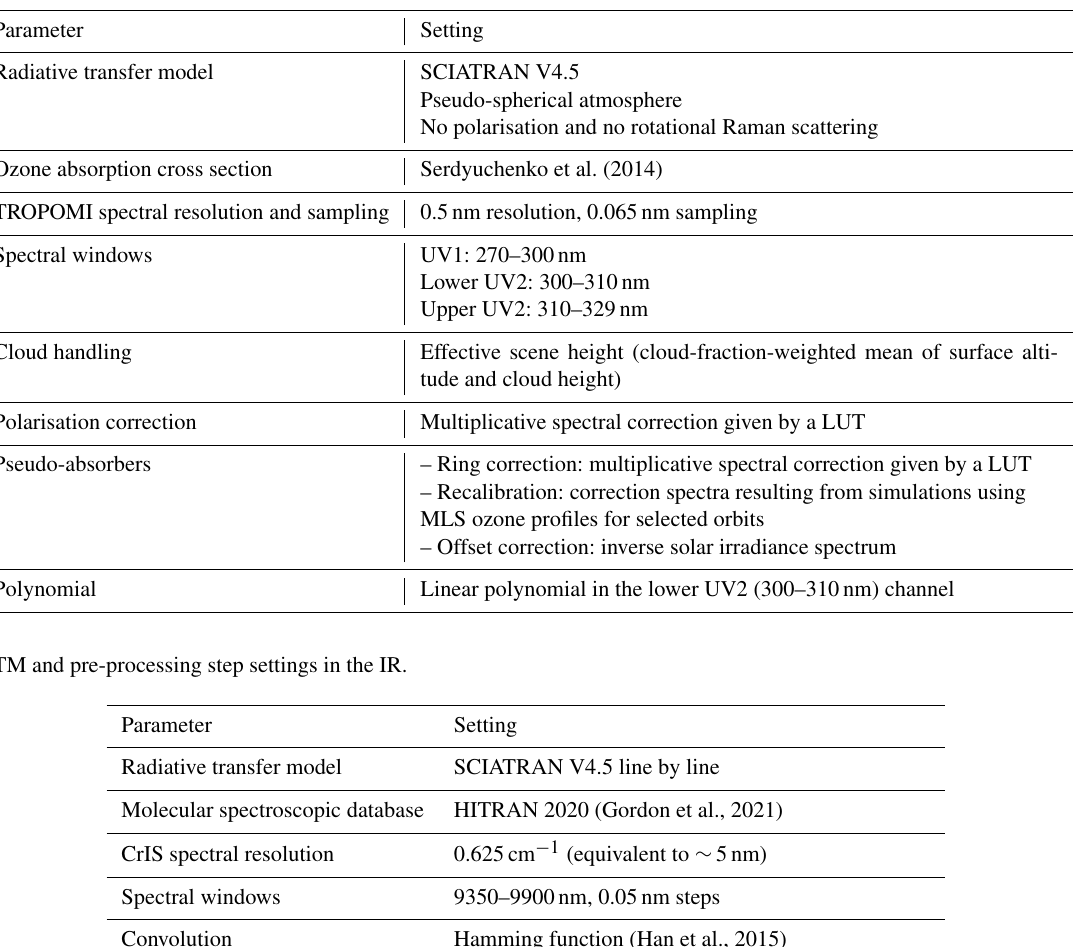
Table 2. RTM and pre-processing step settings in the UV.